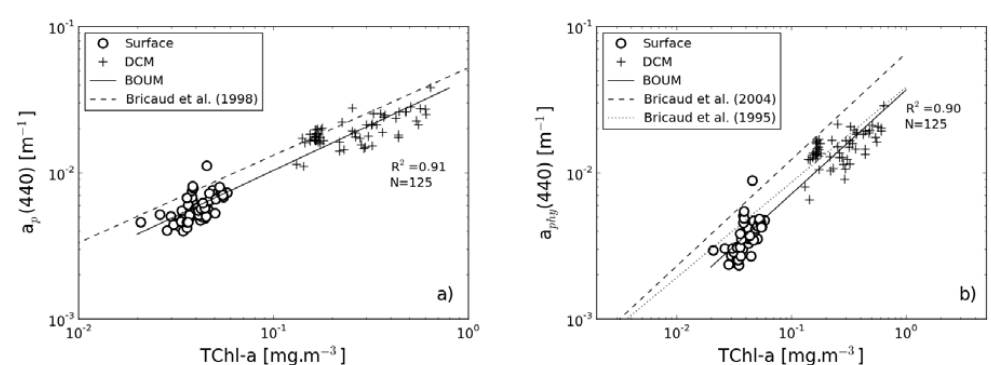
Fig. 5. Variations of the absorption coefficient of (a) particles, a p (440), and (b) phytoplankton, a phy (440), at 440nm as a function of the TChl- a concentration for the surface layer (open circles), and at the DCM (crosses). The solid curves stand for the regression fits corresponding to Eqs. (6) and (5) from measurements performed at the surface and DCM. Previous relationships are also represented as